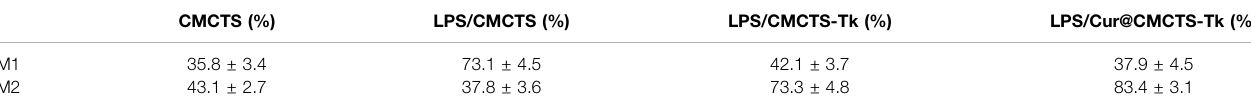
TABLE 1 | The RAW cells M1 and M2 phenotype statistical data (mean ± SD, n (cid:2) 3).